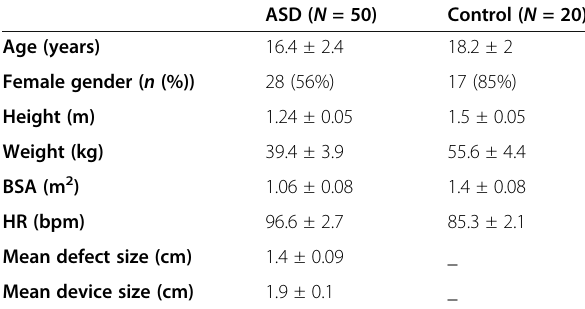
Table 1 Baseline demographic data of the ASD and control cases